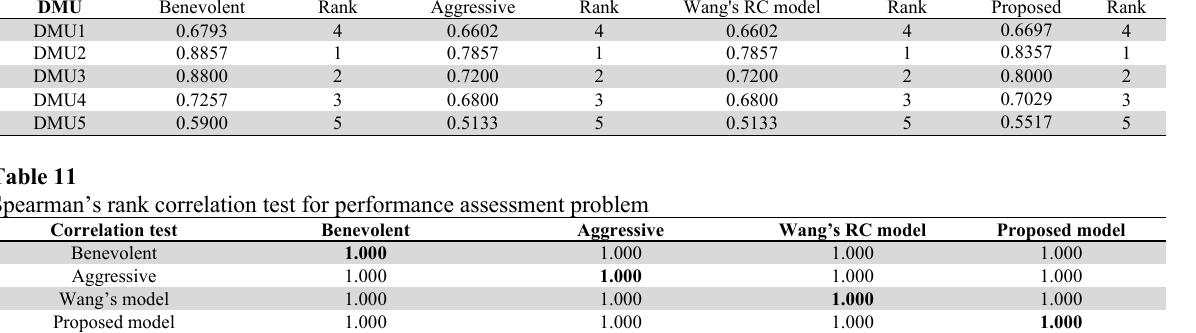
The rating and ranking comparison of the proposed method for a performance assessment problem DMU Rank Rank